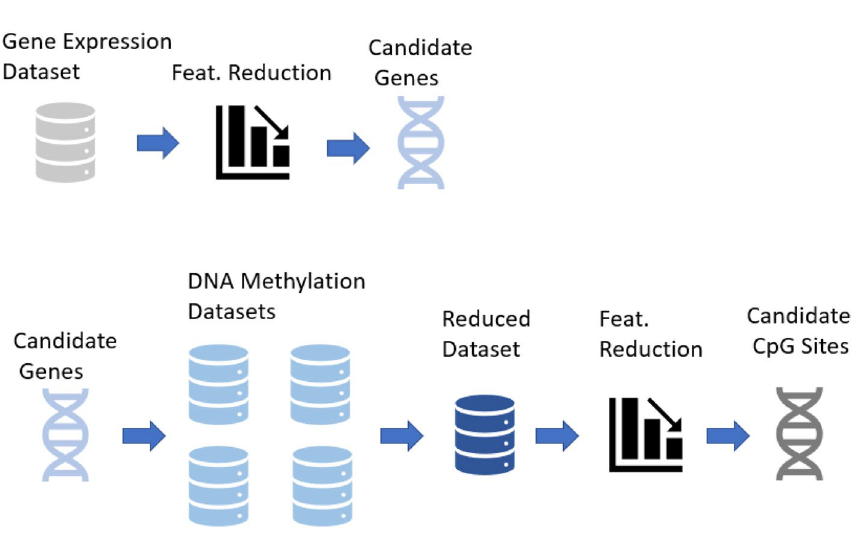
Figure 6. Overview of the pipeline to reduce the number of methylation data probes for REFS by selecting CpGs associated with the candidate